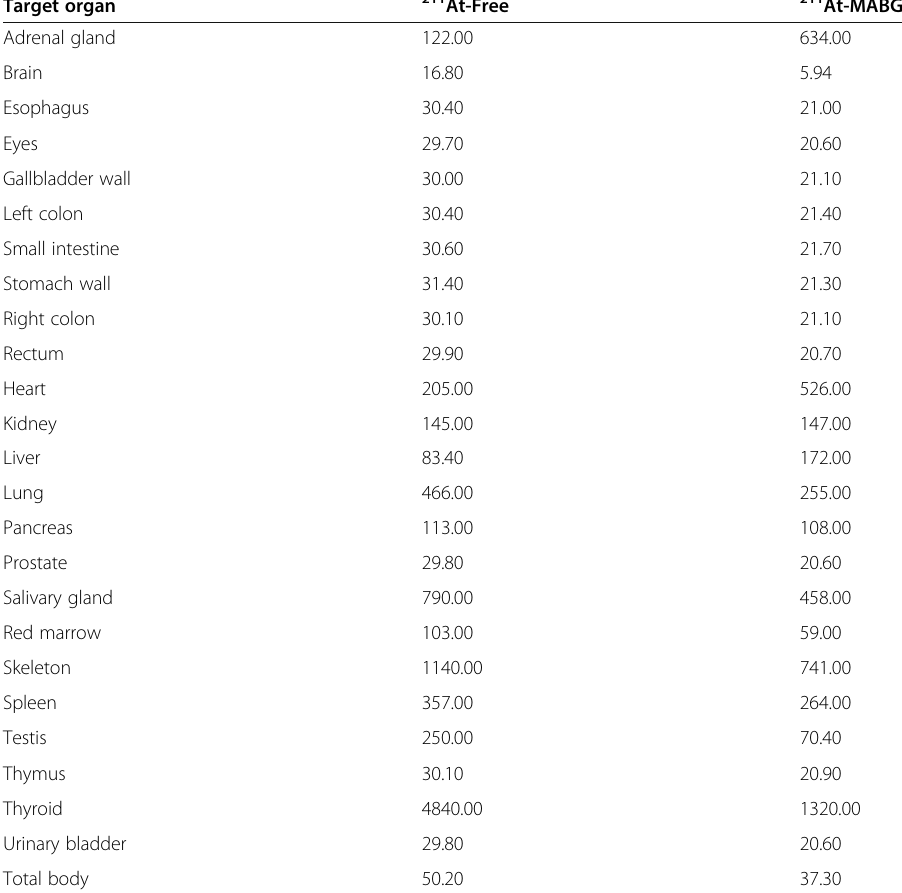
Table 5 Radiation dosimetry estimates per unit administered activity [ μ Gy/MBq] from